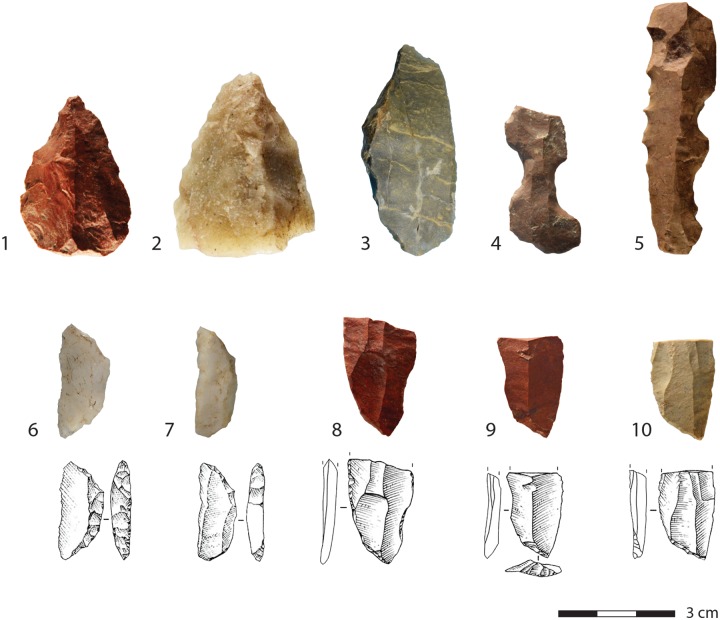
Examples of tools from the HP sequence of KDS.1–2: PAY; 3: PAZ; 4,8: PBE; 5,7: PBC; 6: PBA/PBB; 9–10: PCA. 1,3,4,5,8,9,10: Silcrete; 2: Quartzite; 6–7: Quartzite. Drawings by Gauthier Devilder after [5].